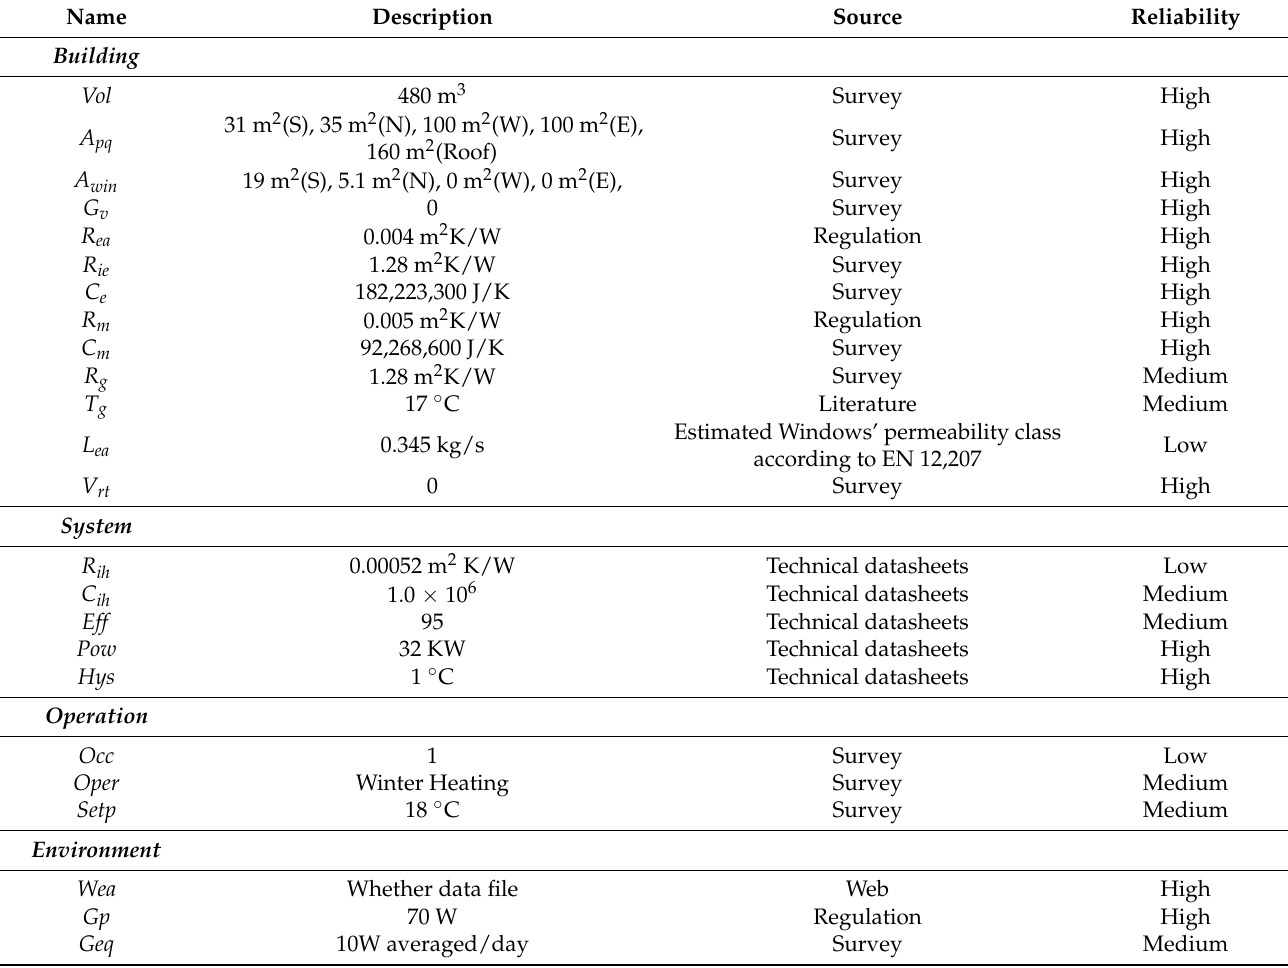
Figure 4. A photo of the property to be assessed ( left ) and of the sketched floor plan made by the operator ( right ). Table 2. The parameter set used for the model